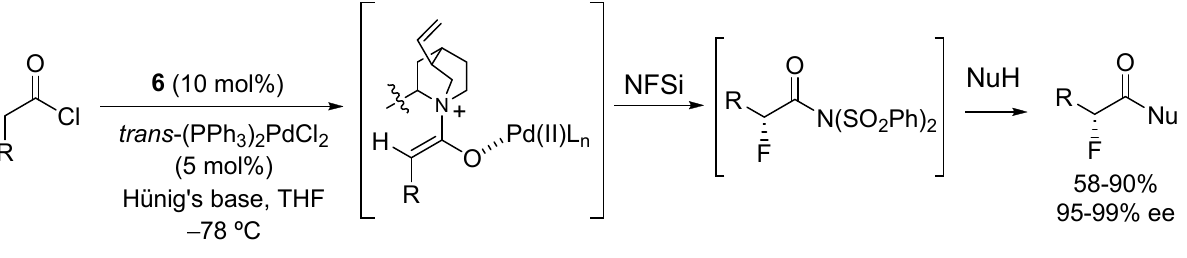
Scheme 6. Catalytic enantioselective α -fluorination of acyl